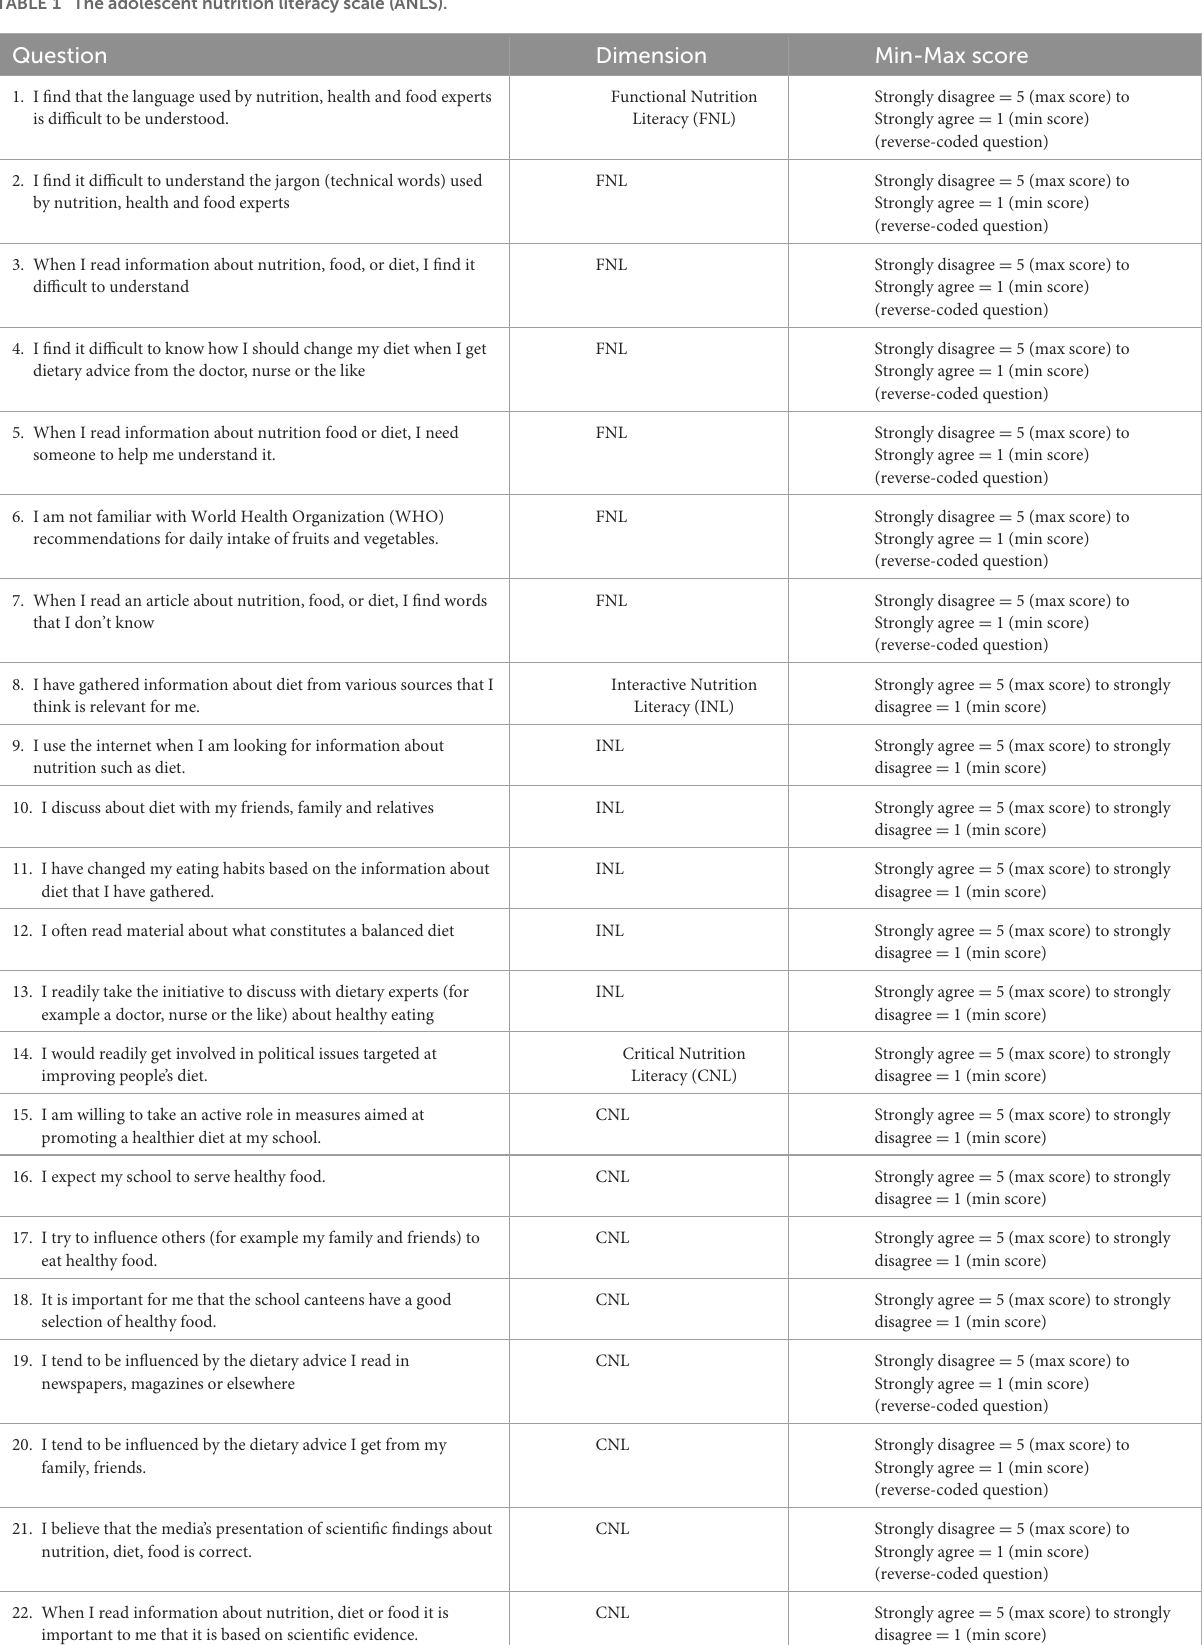
TABLE 1 The adolescent nutrition literacy scale